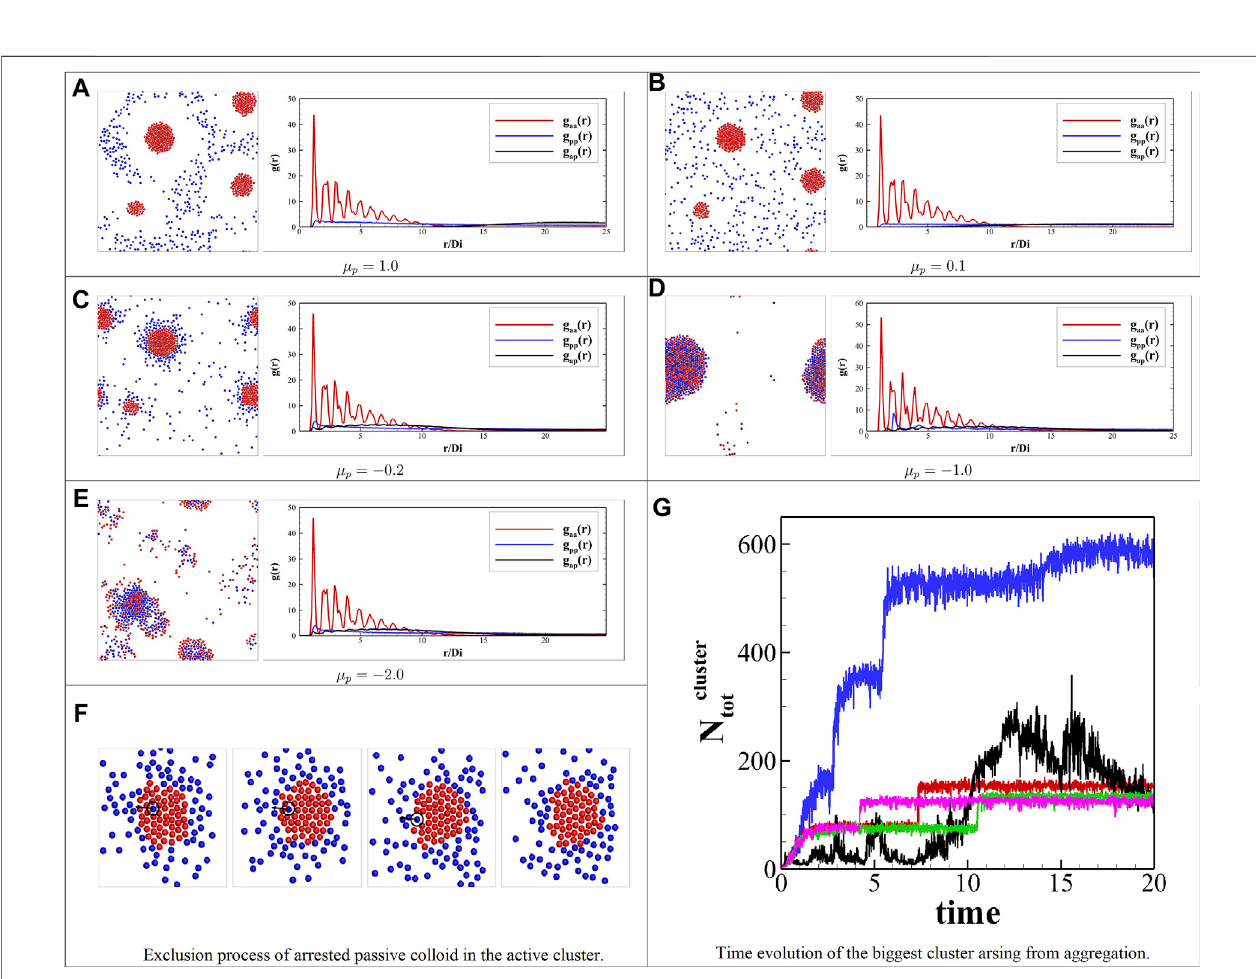
FIGURE 2 | Self-organization observed in the simulation with different surface parameters of passive colloids ’ mobility. The left side shows the snapshots of (A) a schoolof active colloids with an exclusion zone, (B) active colloid clusterssurrounded by the passive colloids, (C) yolk/shell structure, (D) binary active/passive alloy, (E) dynamical clusters. The right side plots the corresponding pair correlation functions from a – e; the red line g aa ( r ) is the pair correlation function for active – active colloids; similarly, the blue line g pp ( r ) is for passive – passive colloids, and the black line g ap ( r ) is for active – passive colloids. The distance is scaled by the diameter (2 R a ) of the active colloid (F) exclusion of a single trapped passive colloid in the active cluster. (G) Time evolution of stoichiometry of the biggest cluster arising from aggregation for different cases; ~ μ p (cid:1) 1 . 0 is the green line; ~ μ p (cid:1) 0 . 1 is the purple line; ~ μ p (cid:1) − 0 . 2 is the red line; ~ μ p (cid:1) − 1 . 0 is the blue line; ~ μ p (cid:1) − 2 . 0 is the black line.